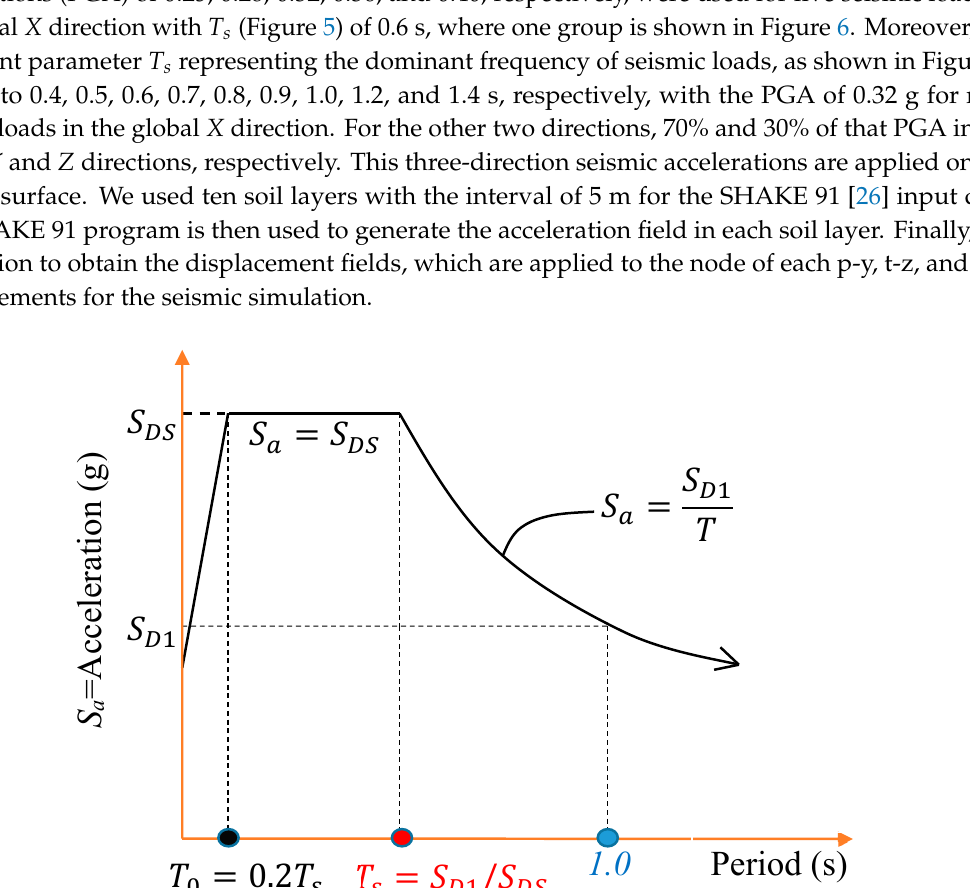
Figure 4. Three-dimensional (3D) Finite element mesh containing the high-tech factory, slabs, rails, and crane (The big and small columns are connected to LRB1 and LRBs, respectively, as shown in Table 2).